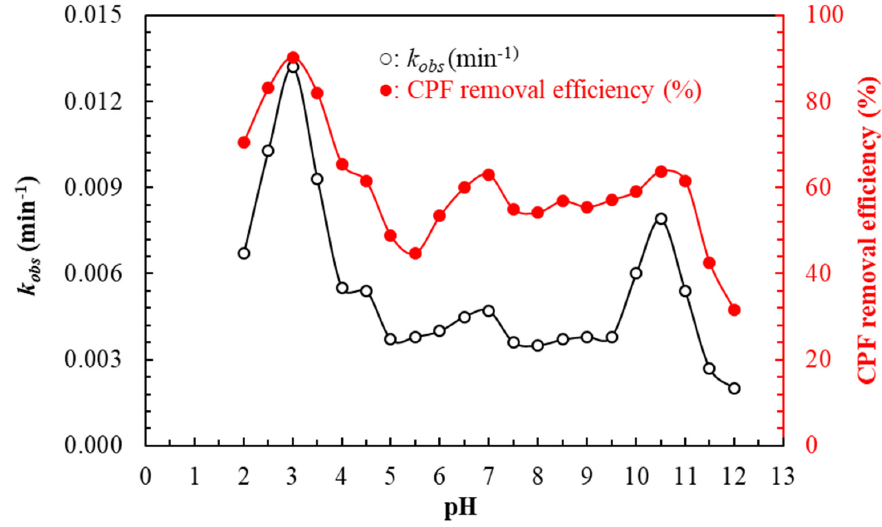
Figure 7. The effects of pH on k obs (min − 1 ) and CPF removal efficiency (%) observed in solar light- assisted oxidative degradation of CPF catalyzed by Fe III -CS-GLA in aqueous solution. Experimental conditions: [CPF] 0 : 50 µM; [Fe III ] 0 in Fe III -CS-GLA: 1.25 mM; [GLA] 0 in Fe III -CS-GLA: 90 mM; [H 2 O 2 ] 0 : 6 mM; volume of CPF solution: 250 mL; pH: 2–12; light intensity: 70,000–90,000 Lux; solar light irradiation time: 180 min.